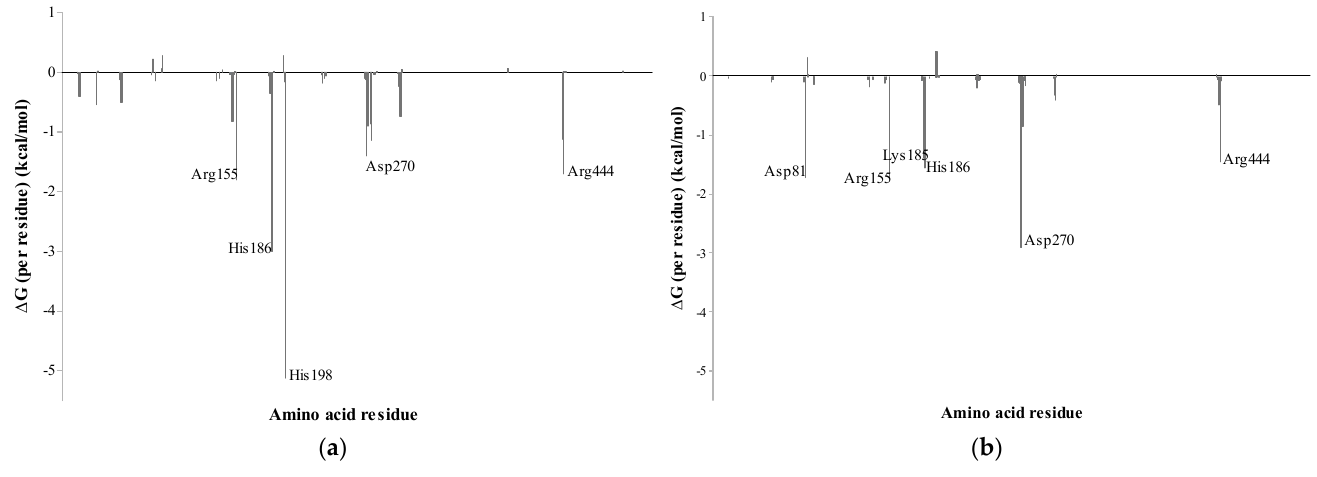
Figure 7. Per-residue binding free energy decomposition of ( a ) MaBgl3–CBI and ( b ) MaBgl3–BGC complexes (in kcal/mol).